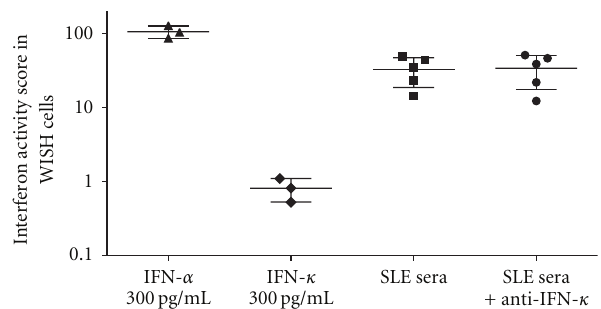
Figure 2: Stimulation of WISH reporter cells with IFN- α , IFN- κ , and SLE sera with and without anti-IFN- κ antibodies. WISH cells were assayed for type I IFN-induced gene expression as described in the methods, using the stimuli indicated on the graph. Anti-IFN- κ antibody was used at a concentration of 10 μ g/mL, and anti-IFN- κ treated sera were preincubated with the antibody for 30 minutes before the sera was applied to the WISH cells. Y -axis shows the IFN-induced gene expression score calculated as described in the Methods. Figure 3: Association analysis of imputed IFNK SNPs. Each